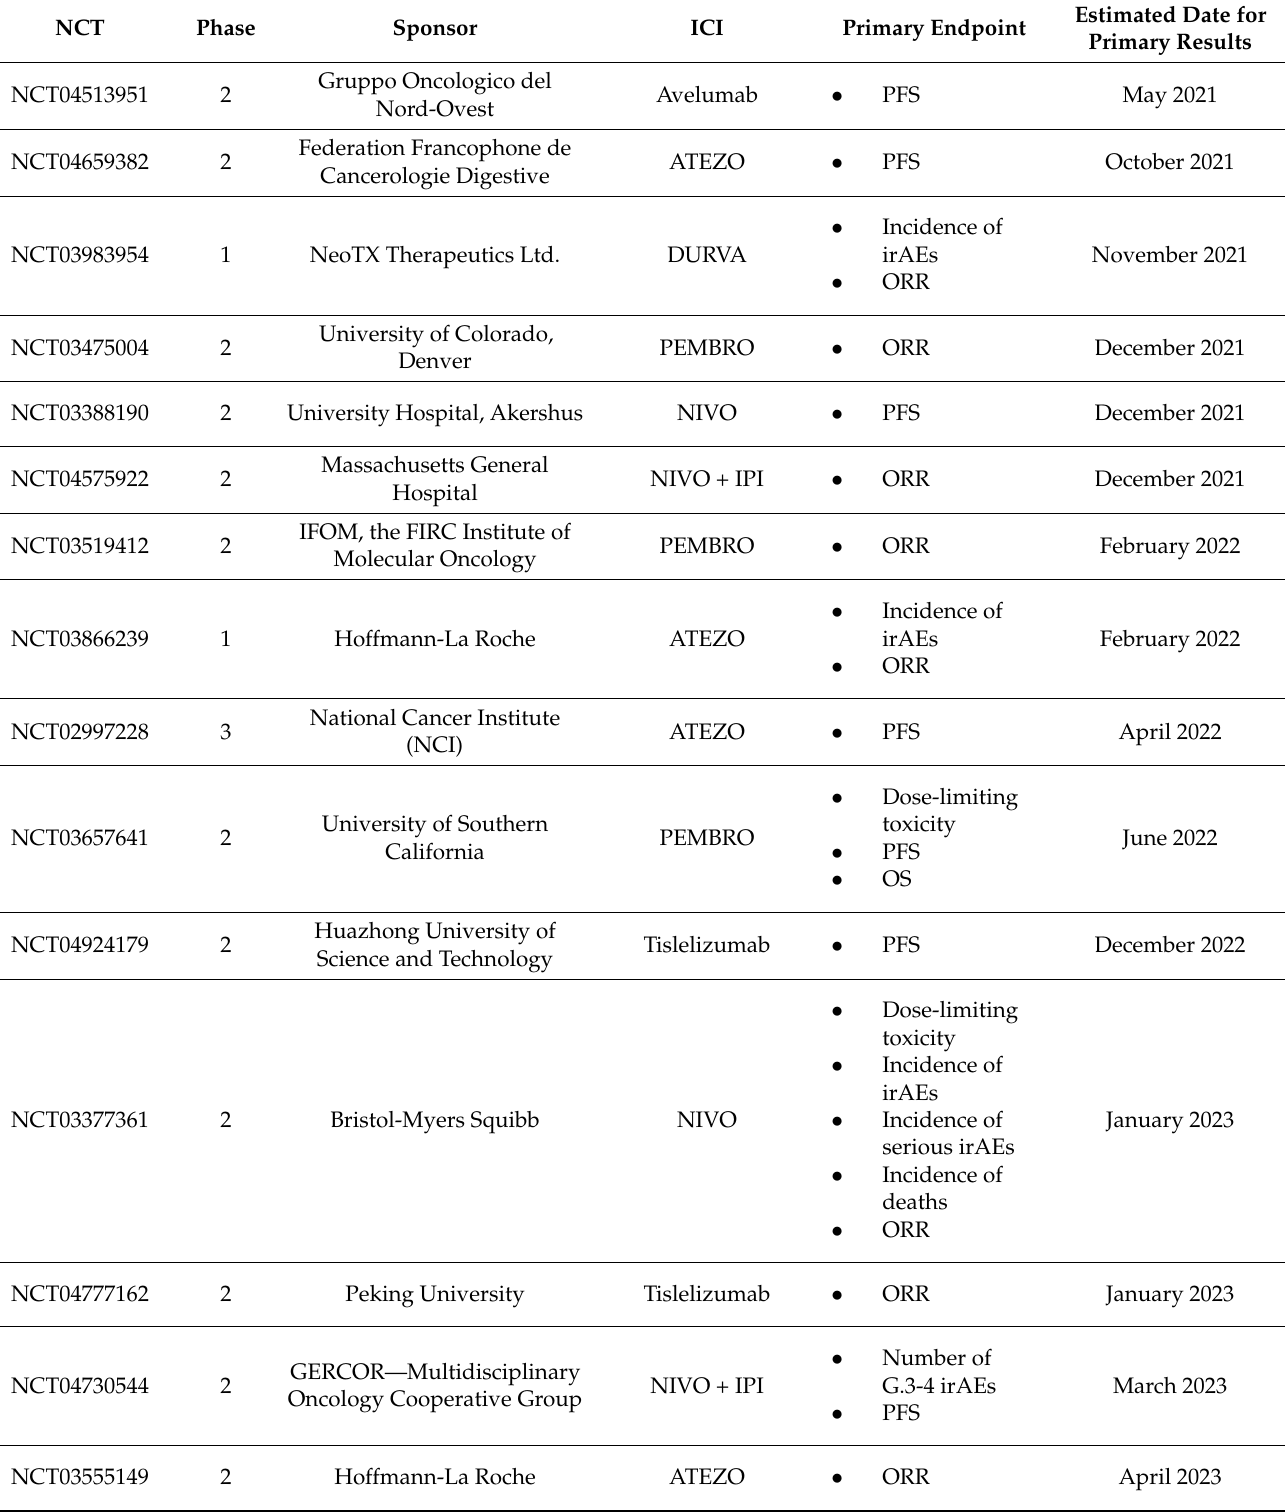
Table 2. List of currently recruiting clinical trials determining clinical outcomes of PD-1/PD-L1/CTLA-4 inhibitors in pa- tients with metastatic colorectal cancer. ICI—immune-checkpoint inhibitor; PEMBRO—pembrolizumab; NIVO—nivolumab; ATEZO—atezolizumab; IPI—ipilimumab; DURVA—durvalumab; ORR—objective response rate;